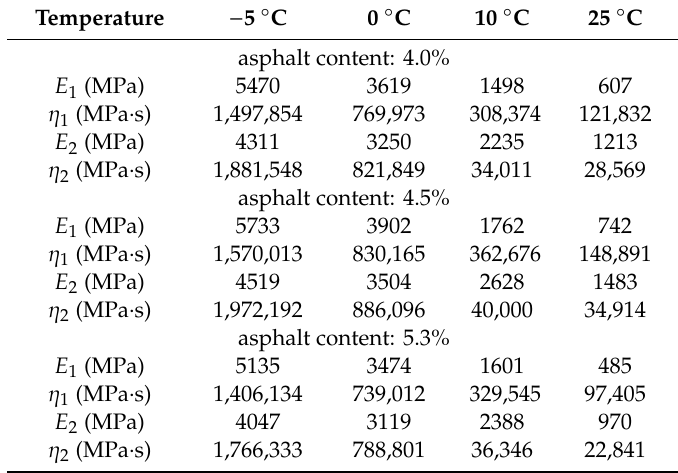
Table 1. Rheological parameters of the Burger’s model obtained for the creep 4BP study.